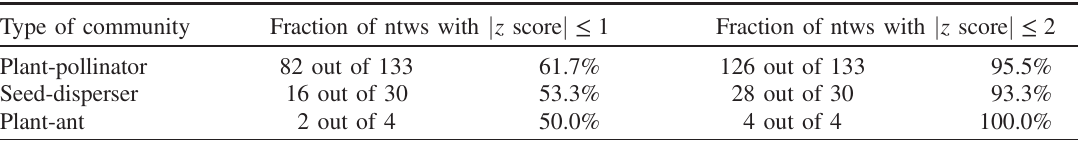
TABLE I. Results disentangled into communities showing the fraction of networks (abbreviated above as “ ntws ” ) whose discrepancy between the real and randomized nestedness is less than or equal to 1 σ or 2 σ . Nestedness is measured with the NODF.